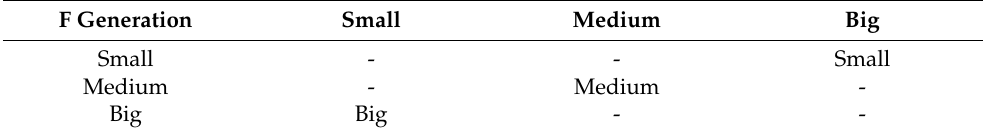
Table 1. Rules of the IT3FDE system.